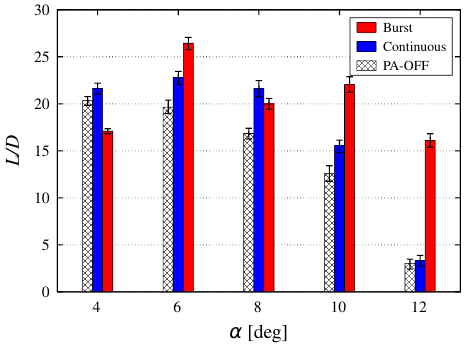
Figure 6. Lift-to-drag ratio ( L / D ) versus angle of attack ( α